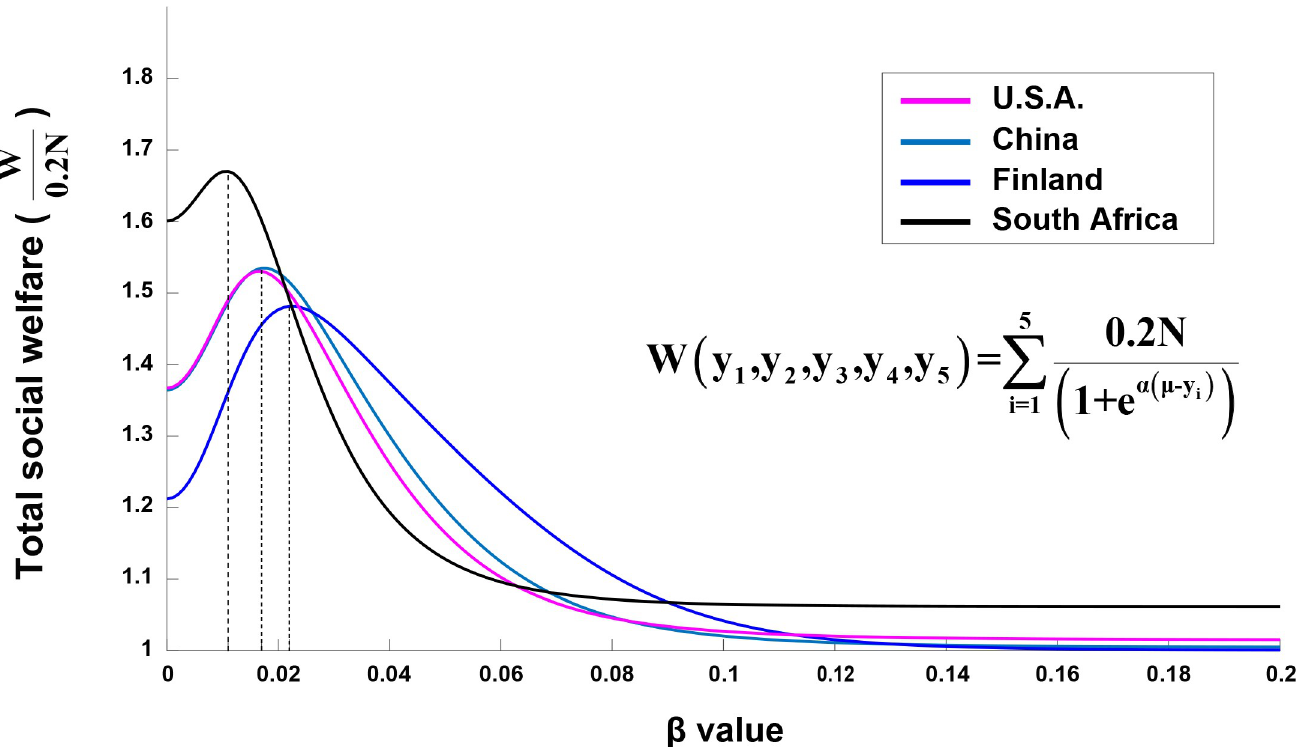
Fig 4. Total social welfare as a function of β value in the four countries. The social welfare plots are normalized to the number of individual households in each subgroup (0.2 N , where N is the total number of individual households in a country). The total social welfare functions of the four countries are maximized at b � ¼ 0 : 017 , b � ¼ 0 : 017 , b � ¼ 0 : 022 , and b � ¼ 0 : 011 . U : S : A : China Finland South Africa